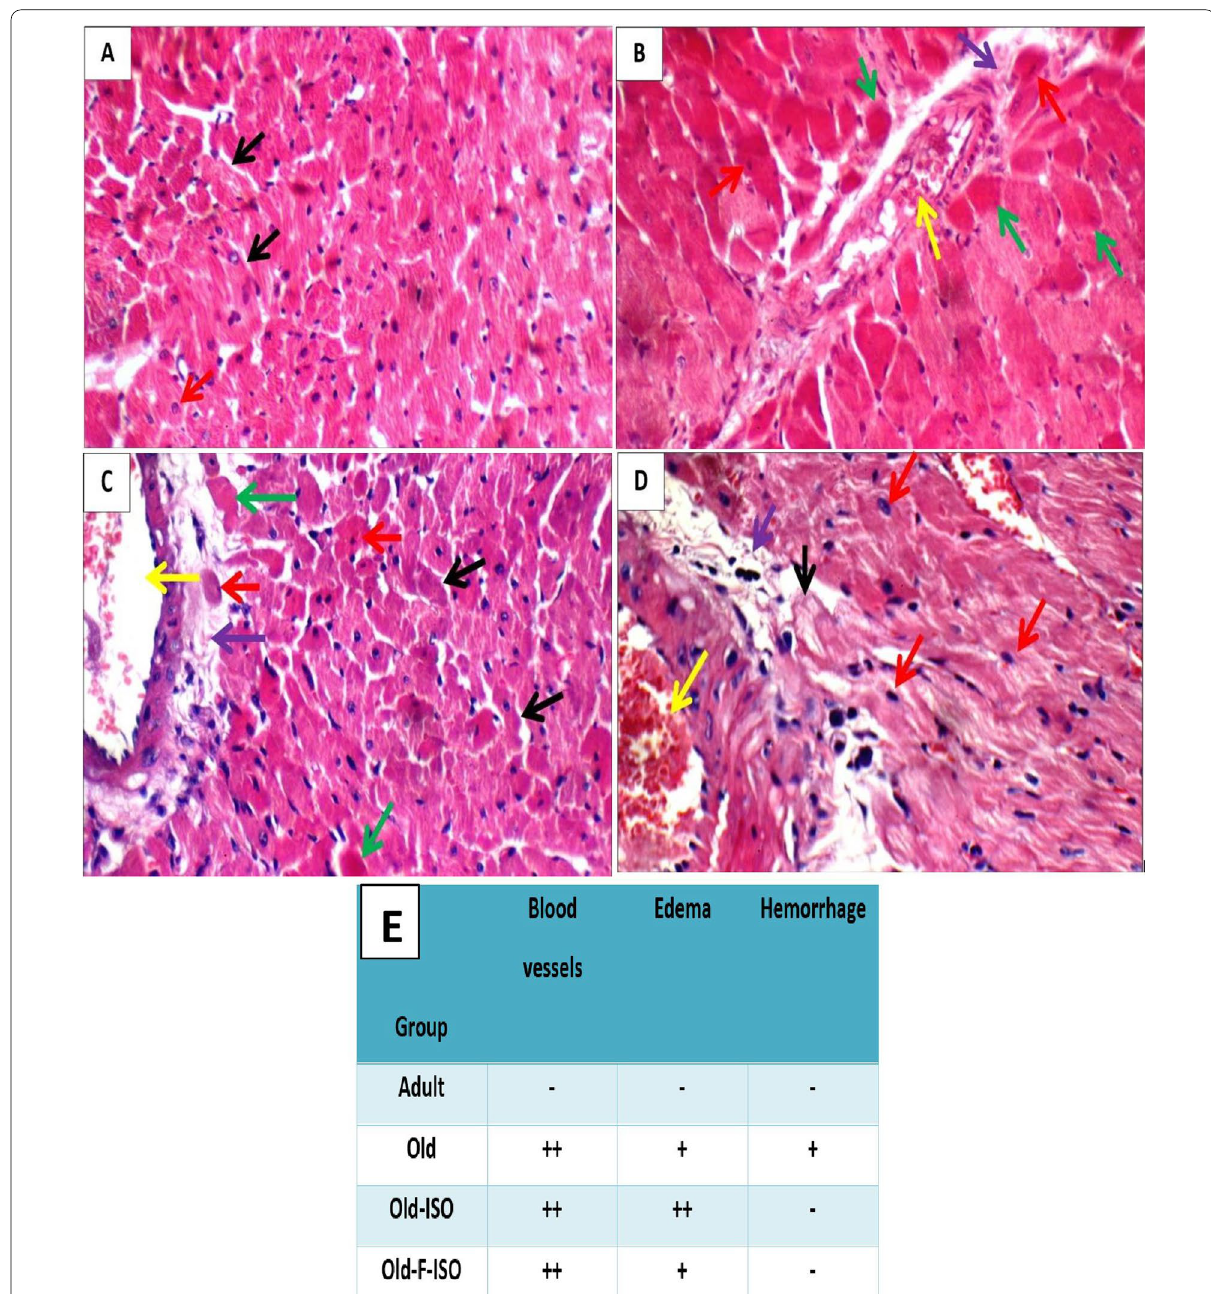
Fig. 3 Photomicrograph of H&E‑stained left ventricle sections of the four studied groups. A Adult group shows average muscle fibers with distinct cell borders (black arrows), and average centrally located nuclei (red arrow) (H&E X 400). B Old group shows most of cardiac muscle fibers with indistinct irregular cell borders and small pyknotic (red arrow) or no nuclei (green arrow), and mildly congested blood vessels (yellow arrow) with mild peri‑vascular edema (purple arrow) (H&E X 400). C Old‑ISO group shows few scattered cardiac muscle fibers with distinct irregular cell borders (black arrow), bright eosinophilic cytoplasm and small pyknotic (red arrow) or no nuclei (green arrow), and mildly dilated congested blood vessels (yellow arrow) with mild peri‑vascular edema (purple arrow) (H&E X 400). D Old‑F‑ISO group shows viable cardiac muscle fibers with distinct regular cell borders (black arrow), and average nuclei (red arrow), and mildly dilated congested blood vessels (yellow arrow) with mild peri‑vascular edema (purple arrow) (H&E X 400). E The histological inflammatory